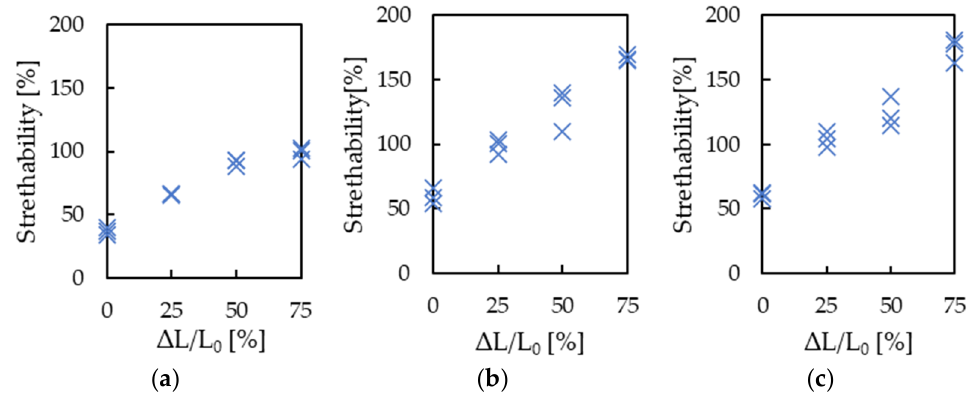
Figure 8. Results of evaluation of stretchability S for each sample made with different types of gear and pre-stretch ratios: ( a ) gears with module 0.1, ( b ) gears with module 0.15, and ( c ) gears with module 0.2.